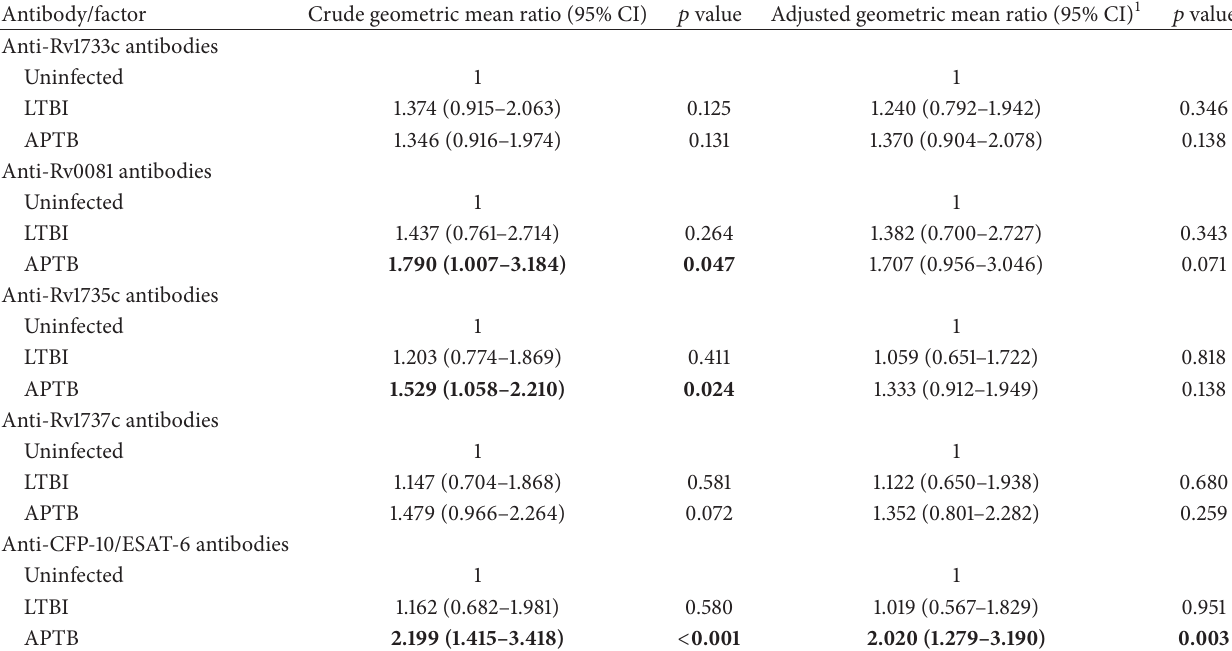
Table 2: Associations between Mycobacterium tuberculosis infection status and concentrations of IgG antibodies to DosR proteins and CFP- 10/ESAT-6 in study